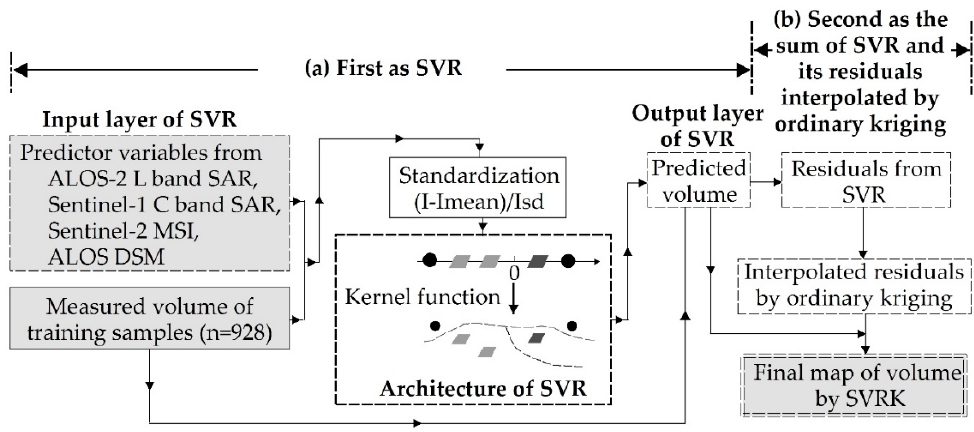
Figure 3. Illustration of support vector machine for regression kriging (SVRK). It includes ( a ) the first step as the support vector machine for regression (SVR) algorithm and ( b ) the second step as the sum of SVR and residuals interpolated by ordinary kriging. I, Imean, and Isd are raw, mean and standard deviation values, respectively.